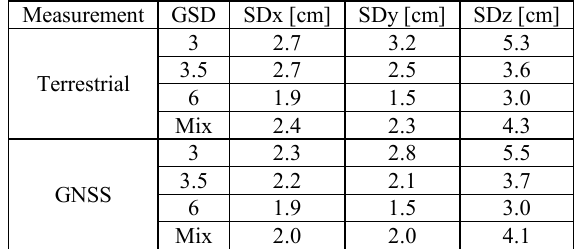
Table 9. Achieved standard deviations of control points and check points measured by RTK GNSS and terrestrial